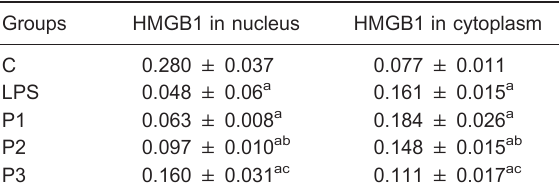
Table 2. NF- k B activity in cell nucleus of mouse macrophages.